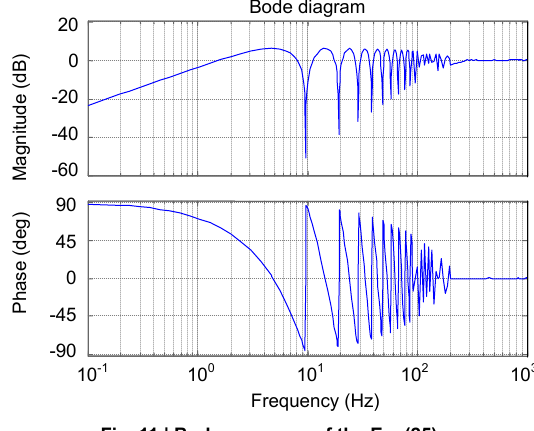
Fig. 11 | Bode response of the Eq. (25).